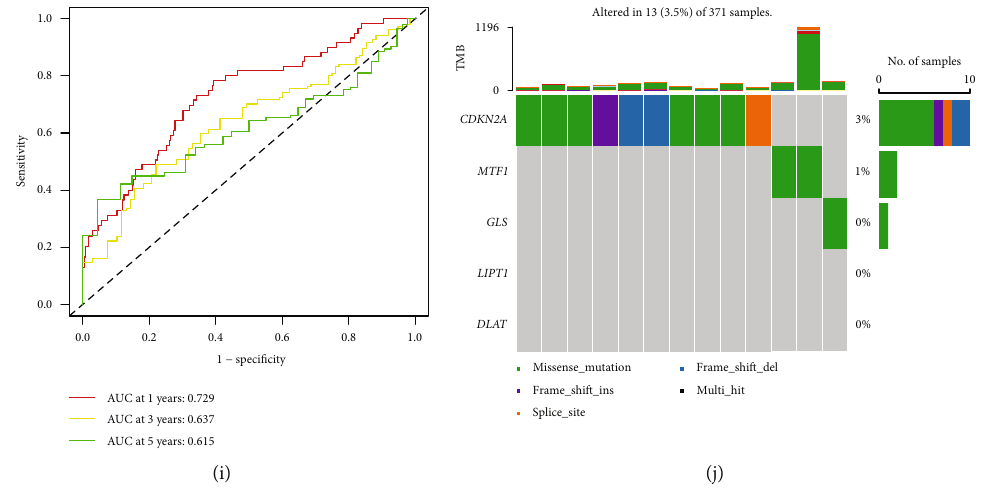
Figure 6: Formation of the risk score signature utilizing fi ve CRGs in the TCGA. (a) Univariate Cox regression analysis selected six CRGs. (b, c) Detection of fi ve prognostic CRGs using the LASSO Cox regression analysis. (d) Heatmaps of the fi ve prognostic CRGs according to the distribution of risk scores. The color legend represents the log2 (FPKM) value. (e) The distribution of risk scores. (f) Patients ’ survival status according to the distribution of risk scores. (g) Kaplan-Meier survival analysis compared the OS between the high-risk and low-risk groups. (h) Kaplan-Meier survival analysis compared the PFS between the high-risk and low-risk groups. (i) The ROC curves for 1, 3, and 5 years of the risk model. (j) Mutation landscape of the fi ve CRGs of the risk